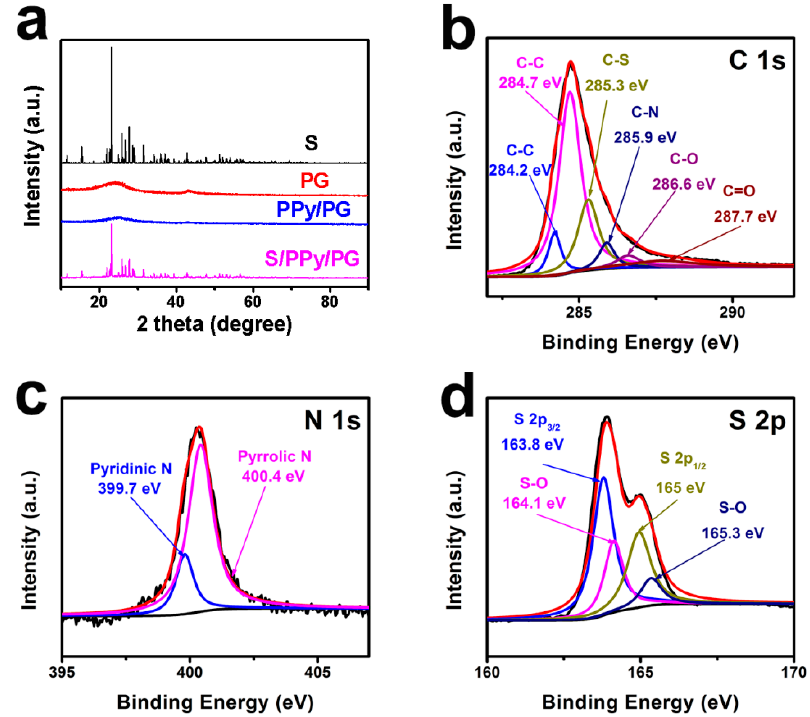
Figure 2. ( a ) XRD patterns of S, PG, PPy/PG and S/PPy/PG composite; high-resolution XPS spectra from core level of ( b ) C 1s, ( c ) N 1s and ( d ) S 2p from S/PPy/PG composite.